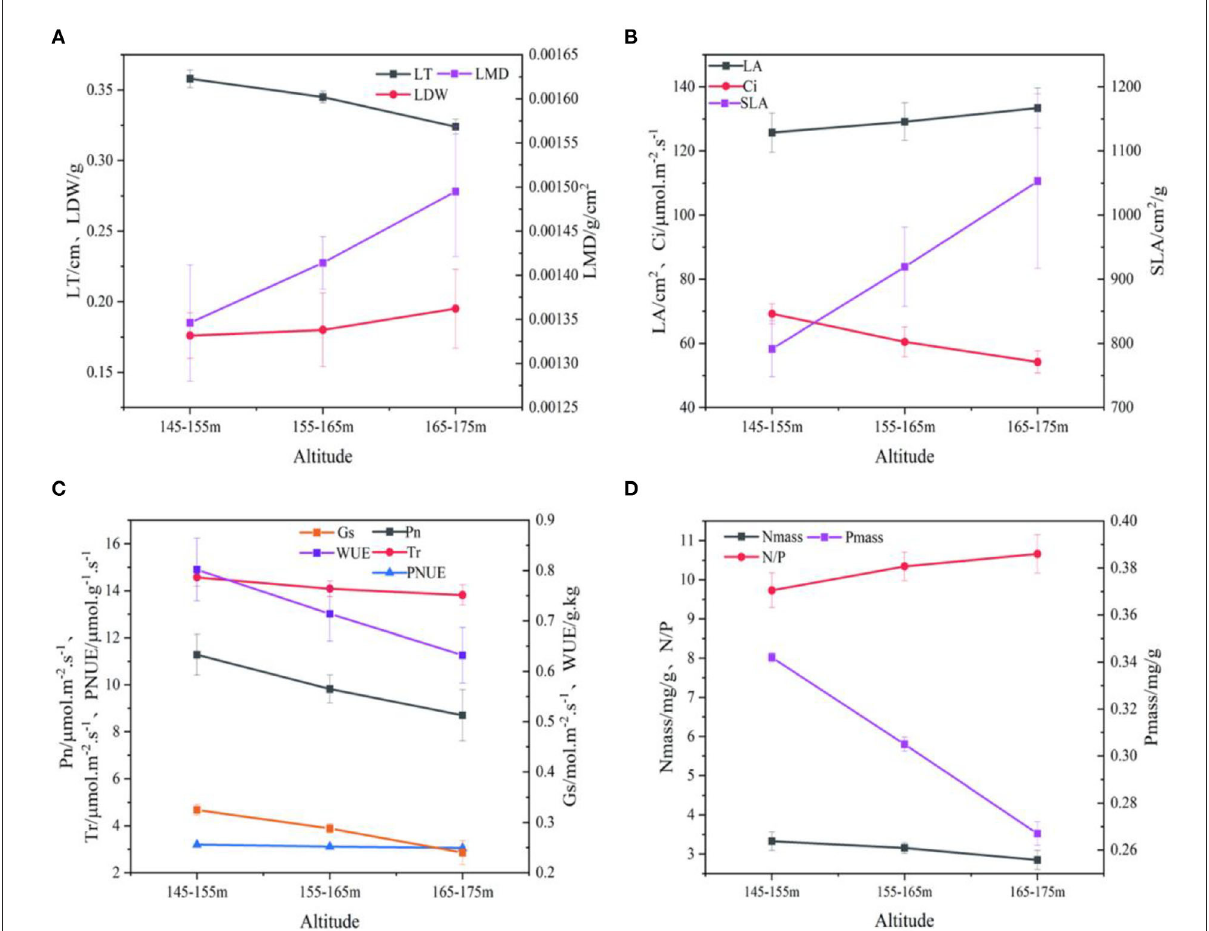
FIGURE2 Relationship between LT, LMD, LDW and elevation gradient (A) . Relationship between LA, Ci, SLA and elevation gradient (B) . Relationship between Gs, Pn, WUE, Tr, PNUE and elevation gradient (C) . Relationship between Nmass, Pmass, N/P and elevation gradient (D) . Leaf functional properties of the fluctuating zone of Three Gorges Reservoir (mean ± SE). LT, leaf thickness; LDW, leaf dry weight; LA, leaf area; Pn, net photosynthetic rate; Gs, stomatal conductance; Tr, transpiration rate; Ci, intercellular CO 2 concentration; SLA, specific leaf area; LMD, leaf mass density; WUE, water use efficiency; Nmass, leaf total nitrogen; Pmass, leaf total phosphorus; N/P, leaf total nitrogen to leaf total phosphorus ratio; PNUE, photosynthetic nitrogen use